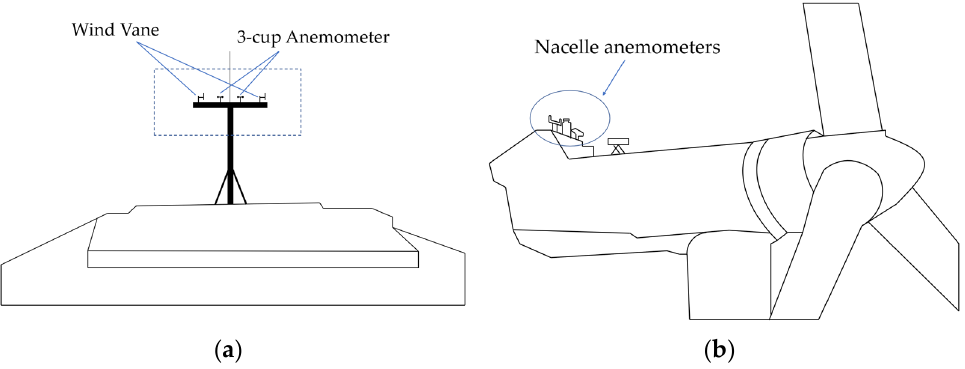
Figure 2. The structure and location of the observation instruments for wind speed in the SCADA system: ( a ) two wind vanes and two 3-cup anemometers are used to measure the wind speed; ( b ) the anemometers are at the rear of the nacelle.